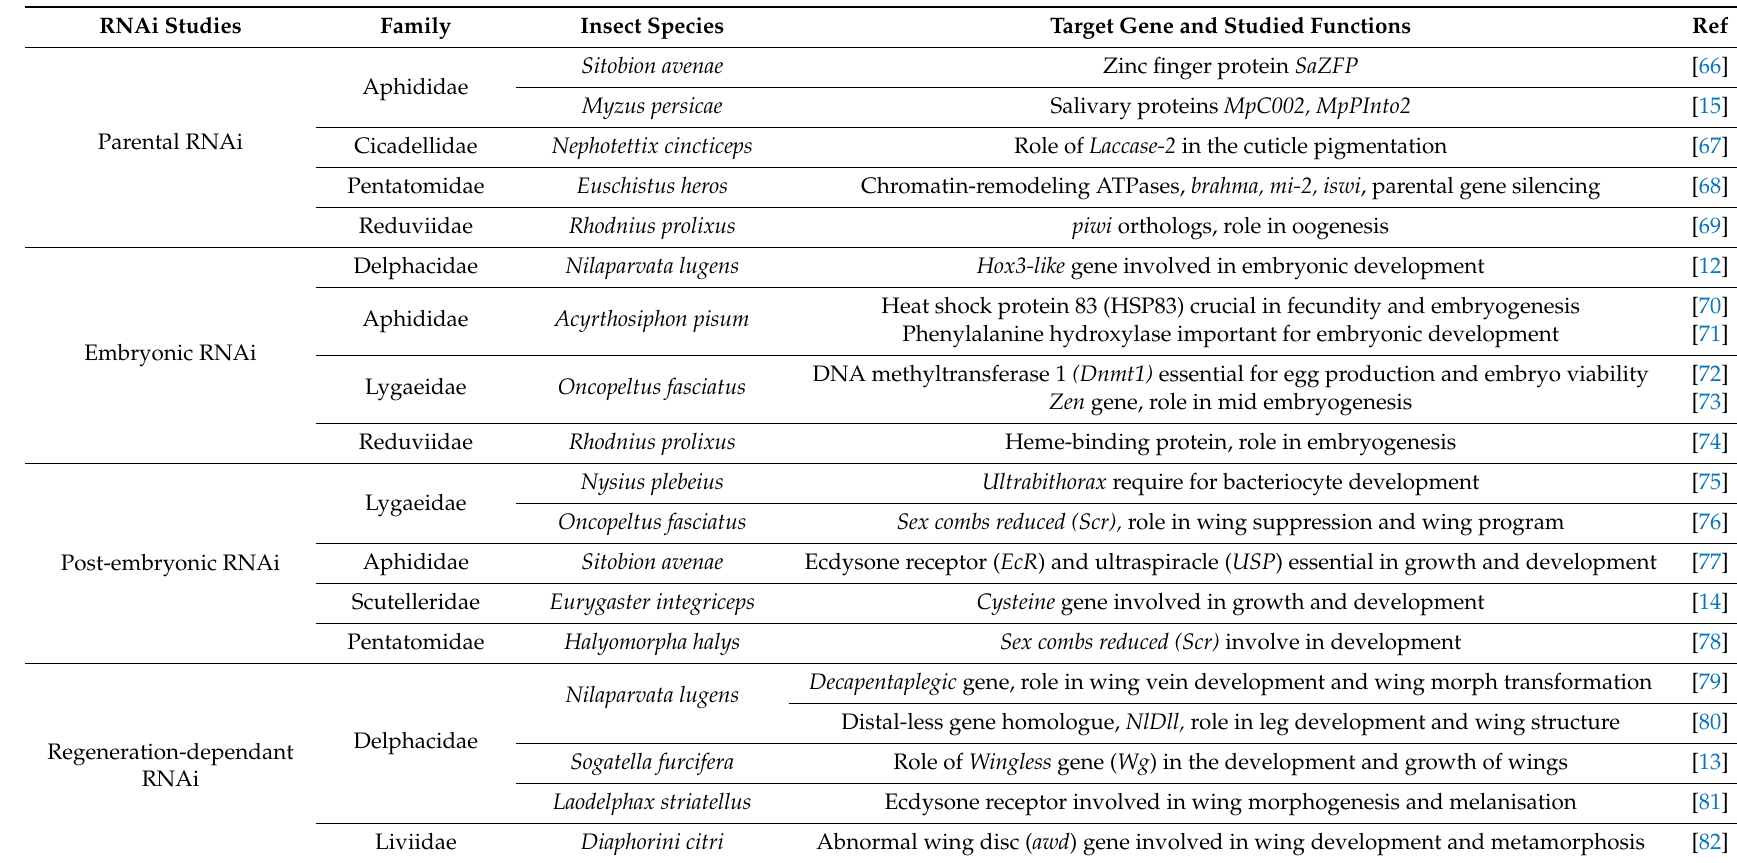
Table 2. Application of RNAi in functional gene studies in hemipteran